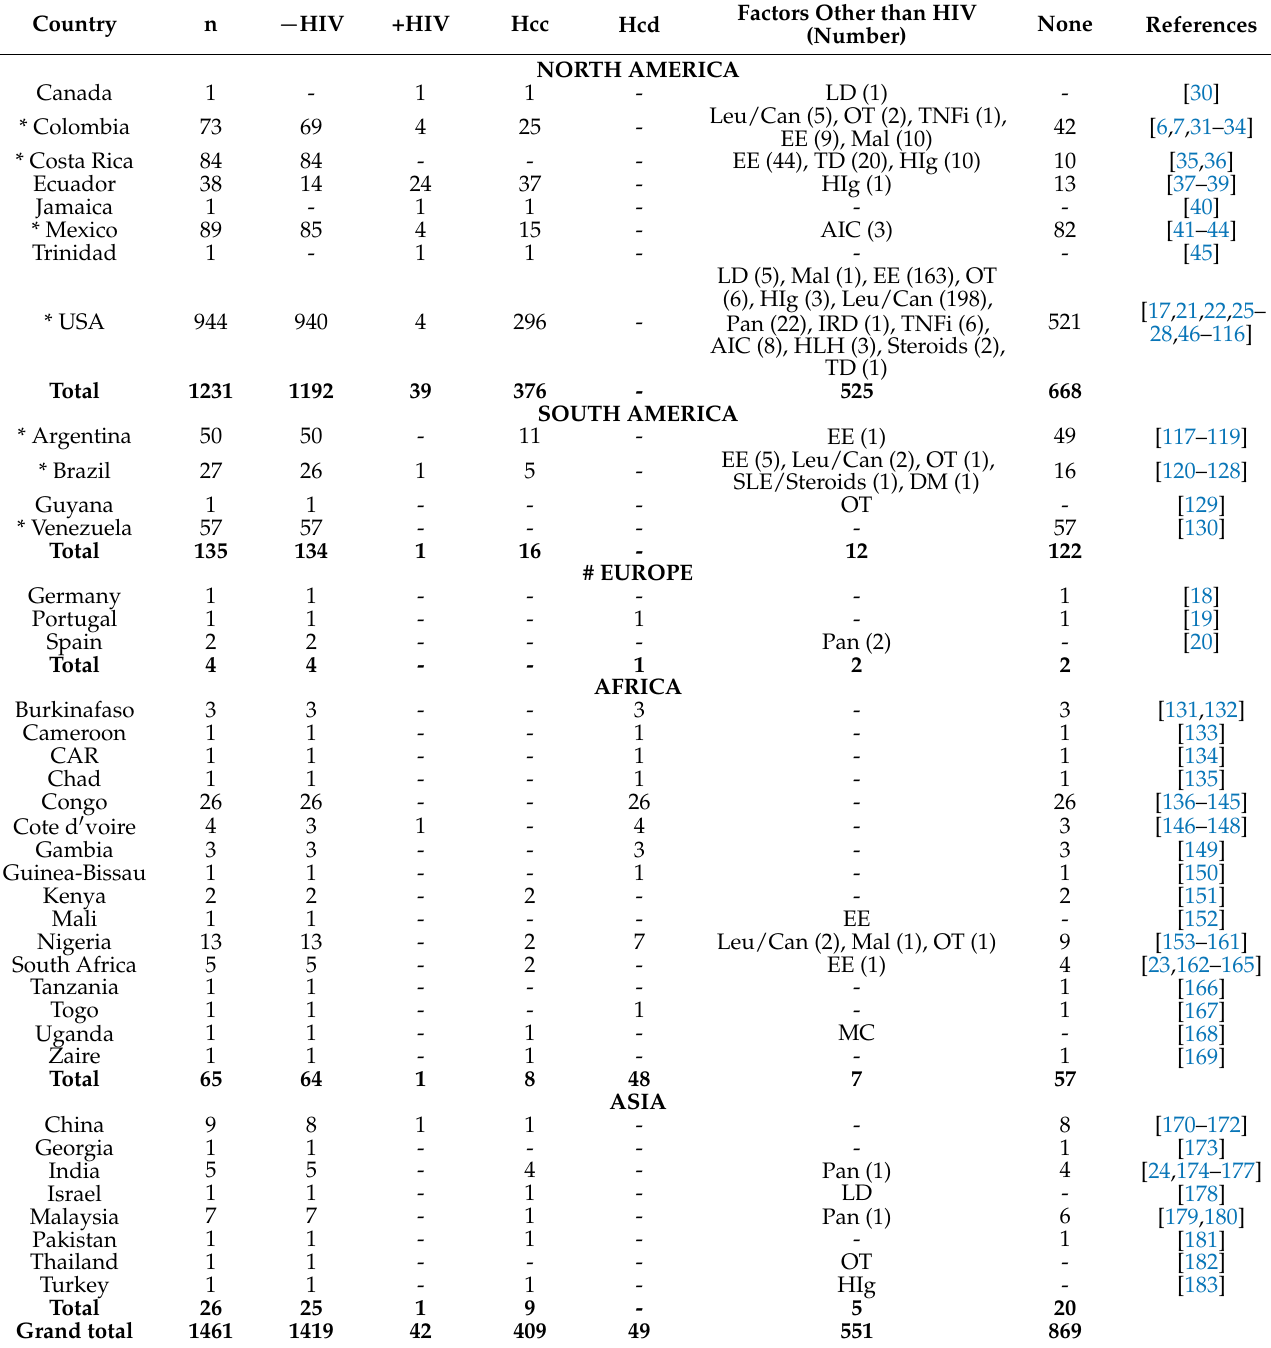
Table 1. Global distribution of Pediatric